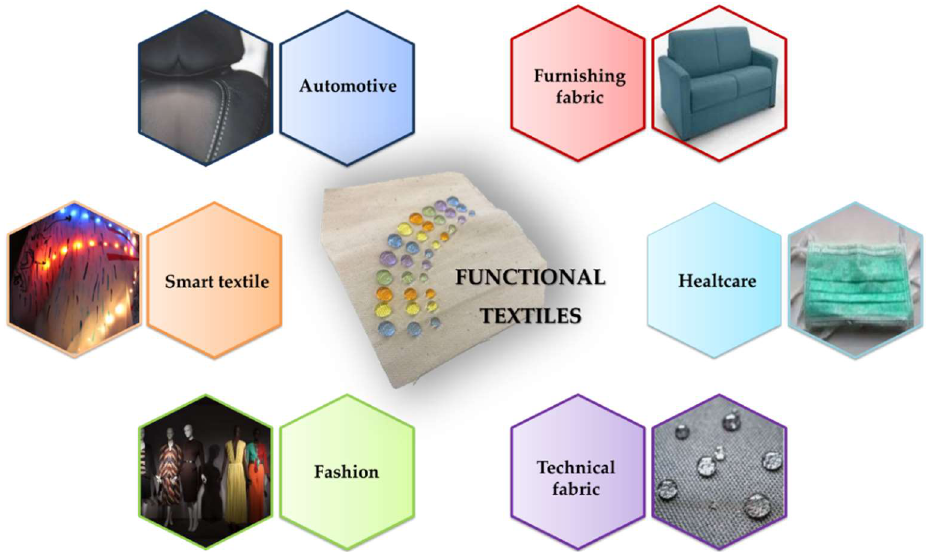
Figure 1. Functional and technical textiles for improved performance, protection, and health: types, application, and market.